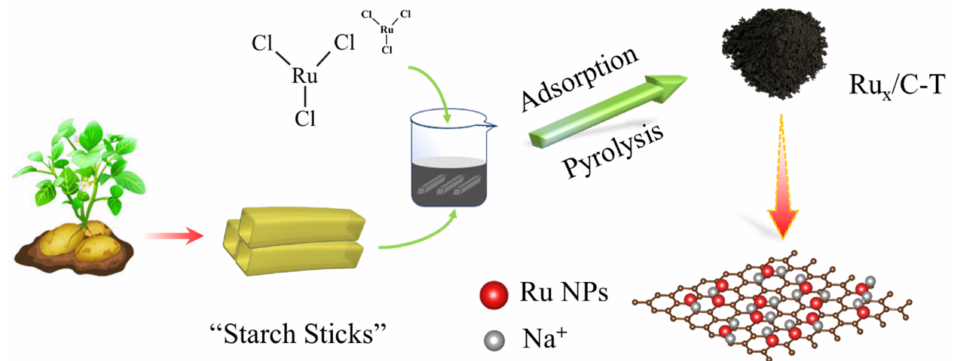
Figure 1. The synthetic procedure for Ru x /C − T